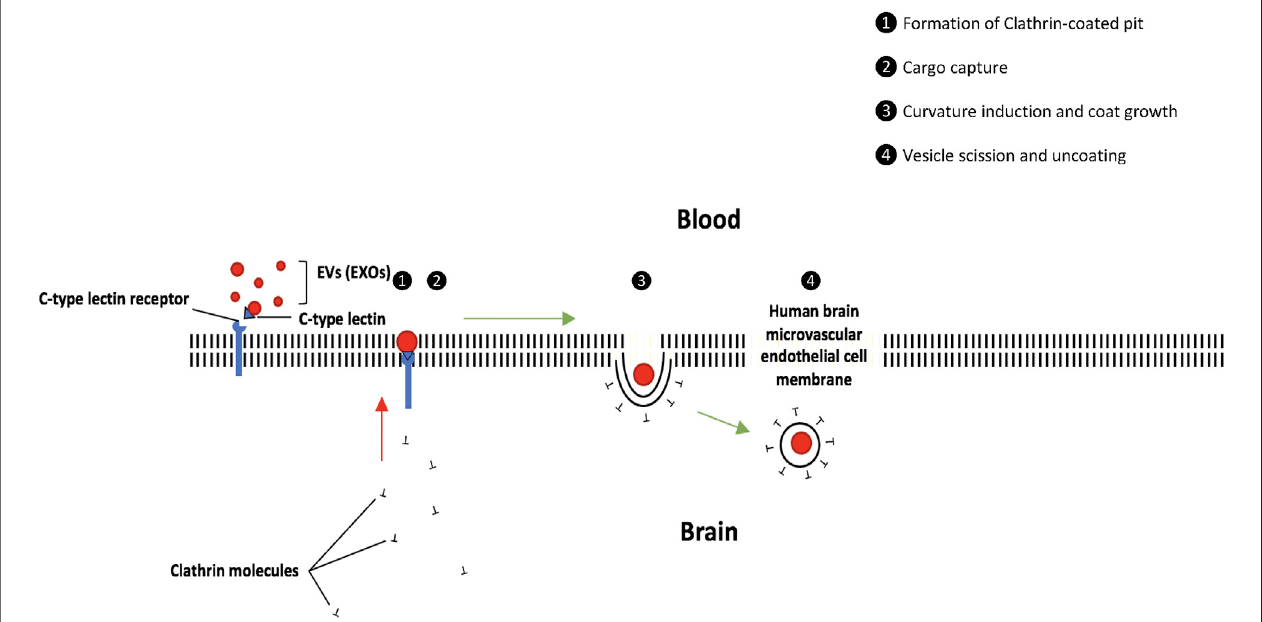
FIGURE 1 | EV uptake via receptor-mediated endocytosis (clathrin-dependent). The ligand – receptor complex triggers a signaling cascade, which causes clathrin molecules to home in the surrounding area of the cell membrane. The following step is the formation of a clathrin-coated vesicle. The cargo-containing vesicle may be directed toward the lysosome for degradation or can be recycled into